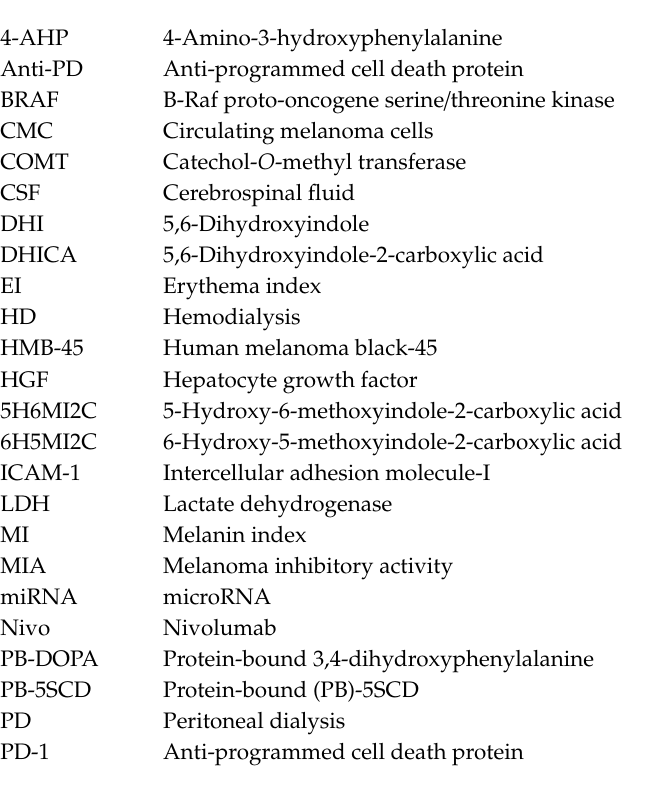
Figure S1: Biosynthesis pathway of eumelanin and pheomelanin; Table S1: Serum and urinary biomarkers for melanoma; Table S2: Patient characteristics; Table S3: Frequency of elevated levels of serum 5SCD according to the presence or absence of